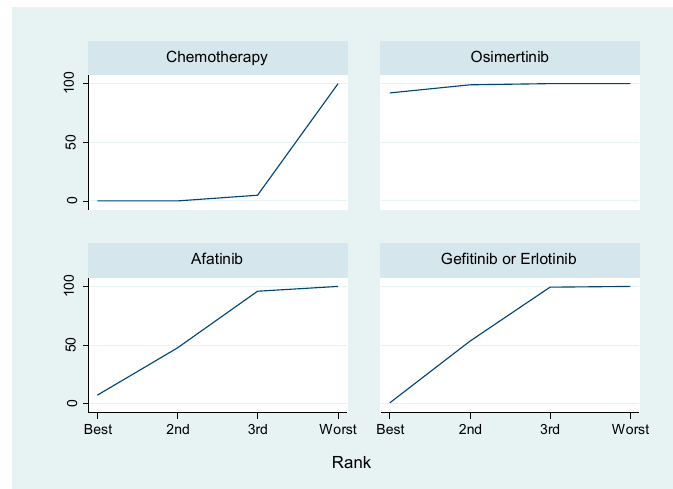
Figure 1. Network meta-analysis of PFS among chemotherapy, gefitinib or erlotinib, afatinib and osimertinib. Data are represented as the cumulative ranking curve. The SUCRA value means the ratio of the area of under the cumulative ranking curve to the total area in the plot and could be utilized to compare each treatment to an ideal treatment which is absolutely and systematically the best. Therefore, a larger SUCRA indicates more effective treatment in the present analysis. PFS; progression-free survival, SUCRA; surface under the cumulative ranking curve.